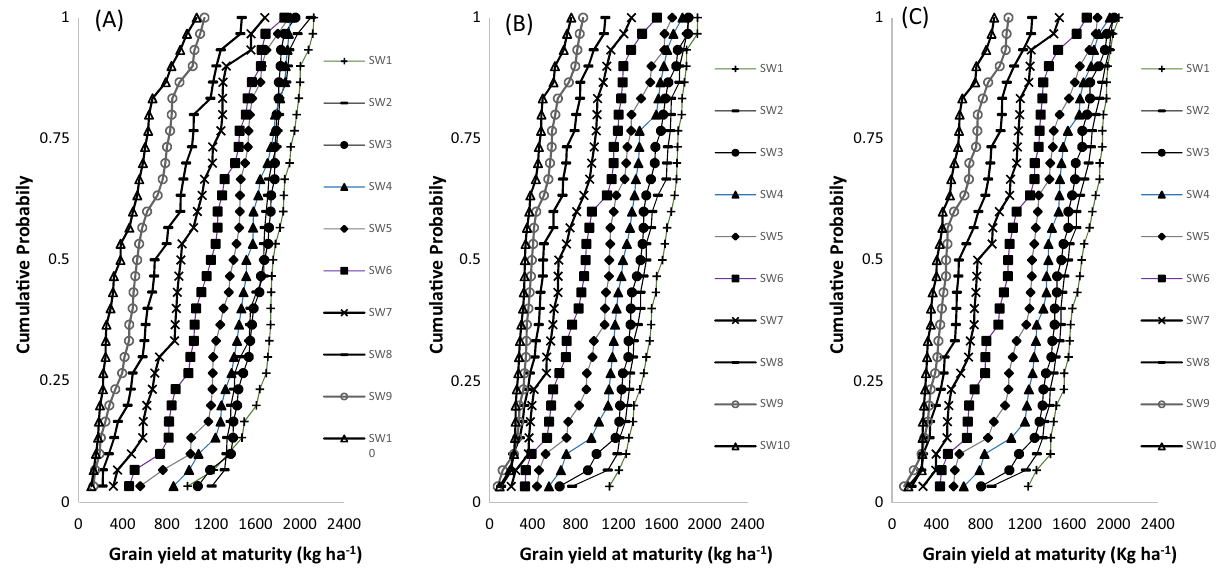
Figure 2. Cumulative function plots for simulated grain yields of TGX1835 ‐ 10E ( A ) TGX1904-6F ( B ) and TGX1951-3F ( C ) in Kano (Sudan savanna) over a 30 ‐ year (1985–2014) period. SW1: June 1–7; SW2: June 8–14; SW3: June 15–June 21; SW4: June 22–28 June; SW5: June 29–July 5; SW6: July 6–July 12; SW7: July 13–July 19; SW8: July 20–July 26; SW9: July 27–August 2; SW10: August 3–August 9.